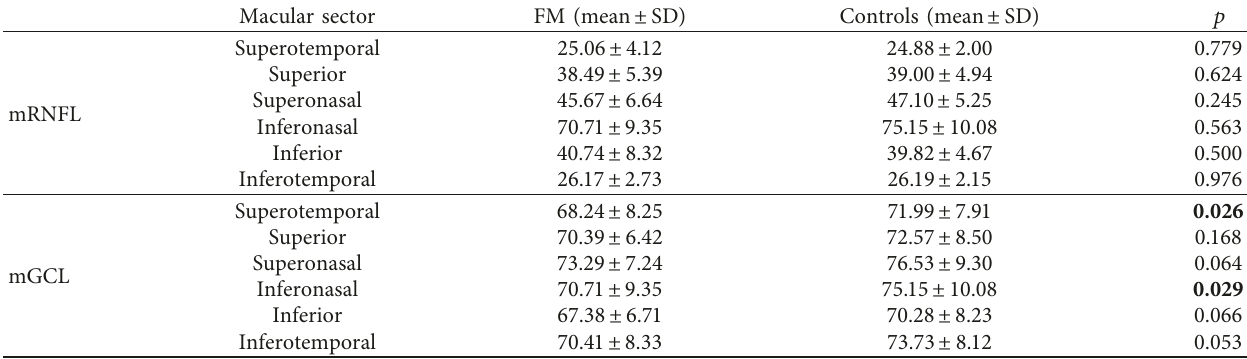
Table 3: Macular structural analysis (in microns) of the retinal nerve fiber layer and the ganglion cell layer in patients with fibromyalgia and healthy subjects using swept-source Triton optical coherence tomography. Bold numbers indicate p < 0 . 05. The significance according to the Bonferroni’s correction was calculated as p < 0 . 007.